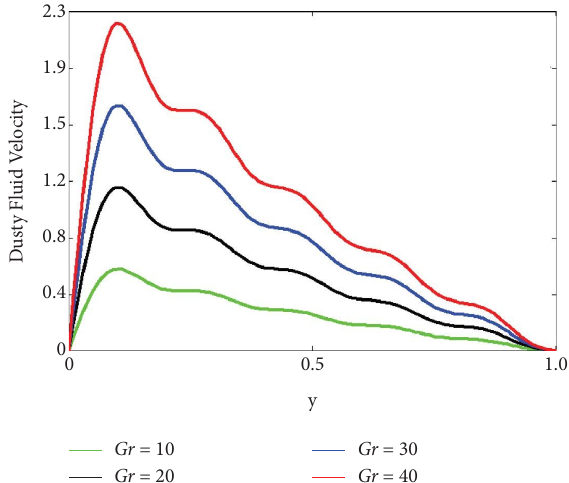
Figure 9: Te impact of diferent values of Gr on ψ